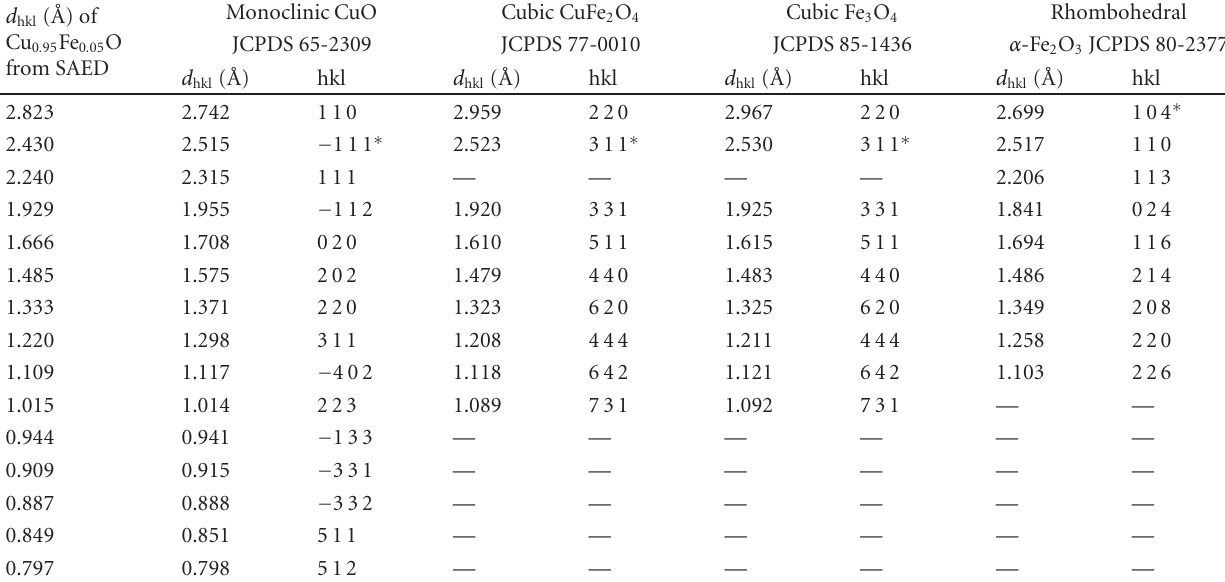
∗ Indicates the respective 100%